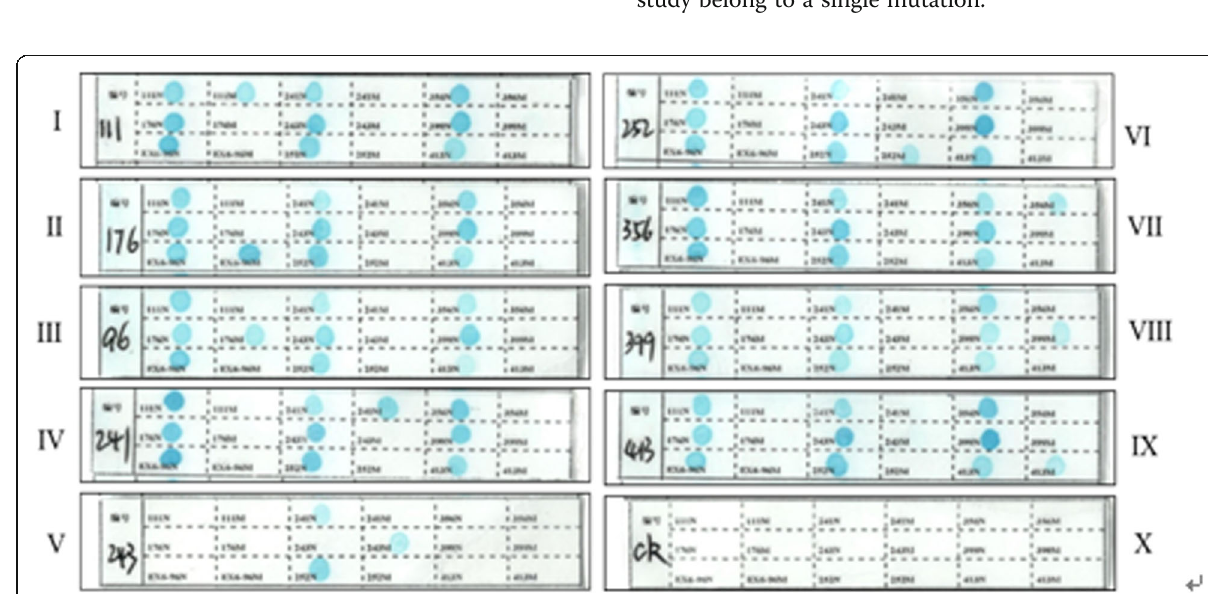
Fig. 3 Representative results detected by reverse dot hybridization of 9 common PAH gene mutations in the Chinese population